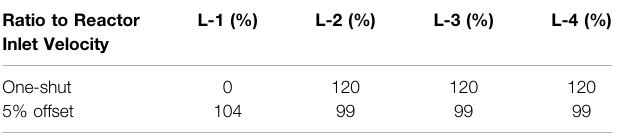
TABLE 5 | Test requirements and conditions for unbalance inlet fl ow.